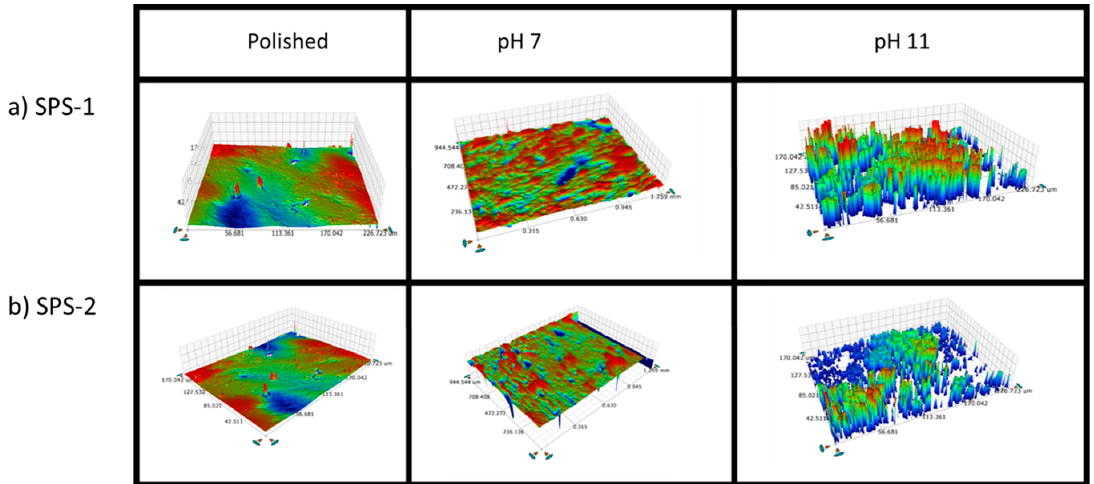
Figure 17. Optical profilometry images before and after the SPFT experiments at pH 7 and pH 11 of: ( a ) SPS-1; and ( b ) SPS-2.